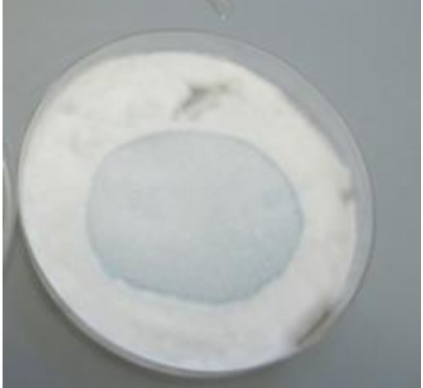
Figure 8. Printed sample after antibacterial